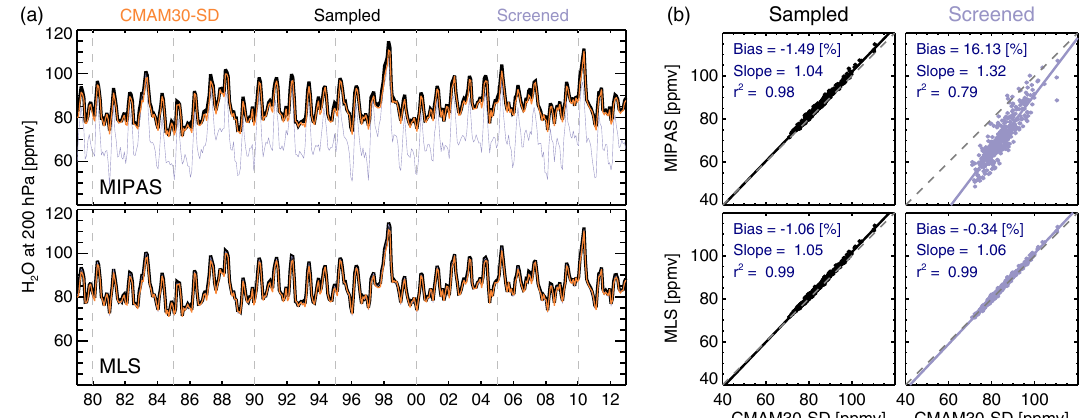
Figure 5. (a) Time series of 20 ◦ S–20 ◦ N H 2 O at 200hPa for the raw CMAM30-SD fields (orange lines), the full satellite-sampled fields (black lines), and only those points passing the quality screening criteria (thin purple lines) for MIPAS and MLS. (b) Scatter plots between these time series. The dashed gray lines are the 1 : 1 line, and the solid lines are the linear best fits, whose slopes are given. Also, the coefficient of determination, r 2 , and the bias are